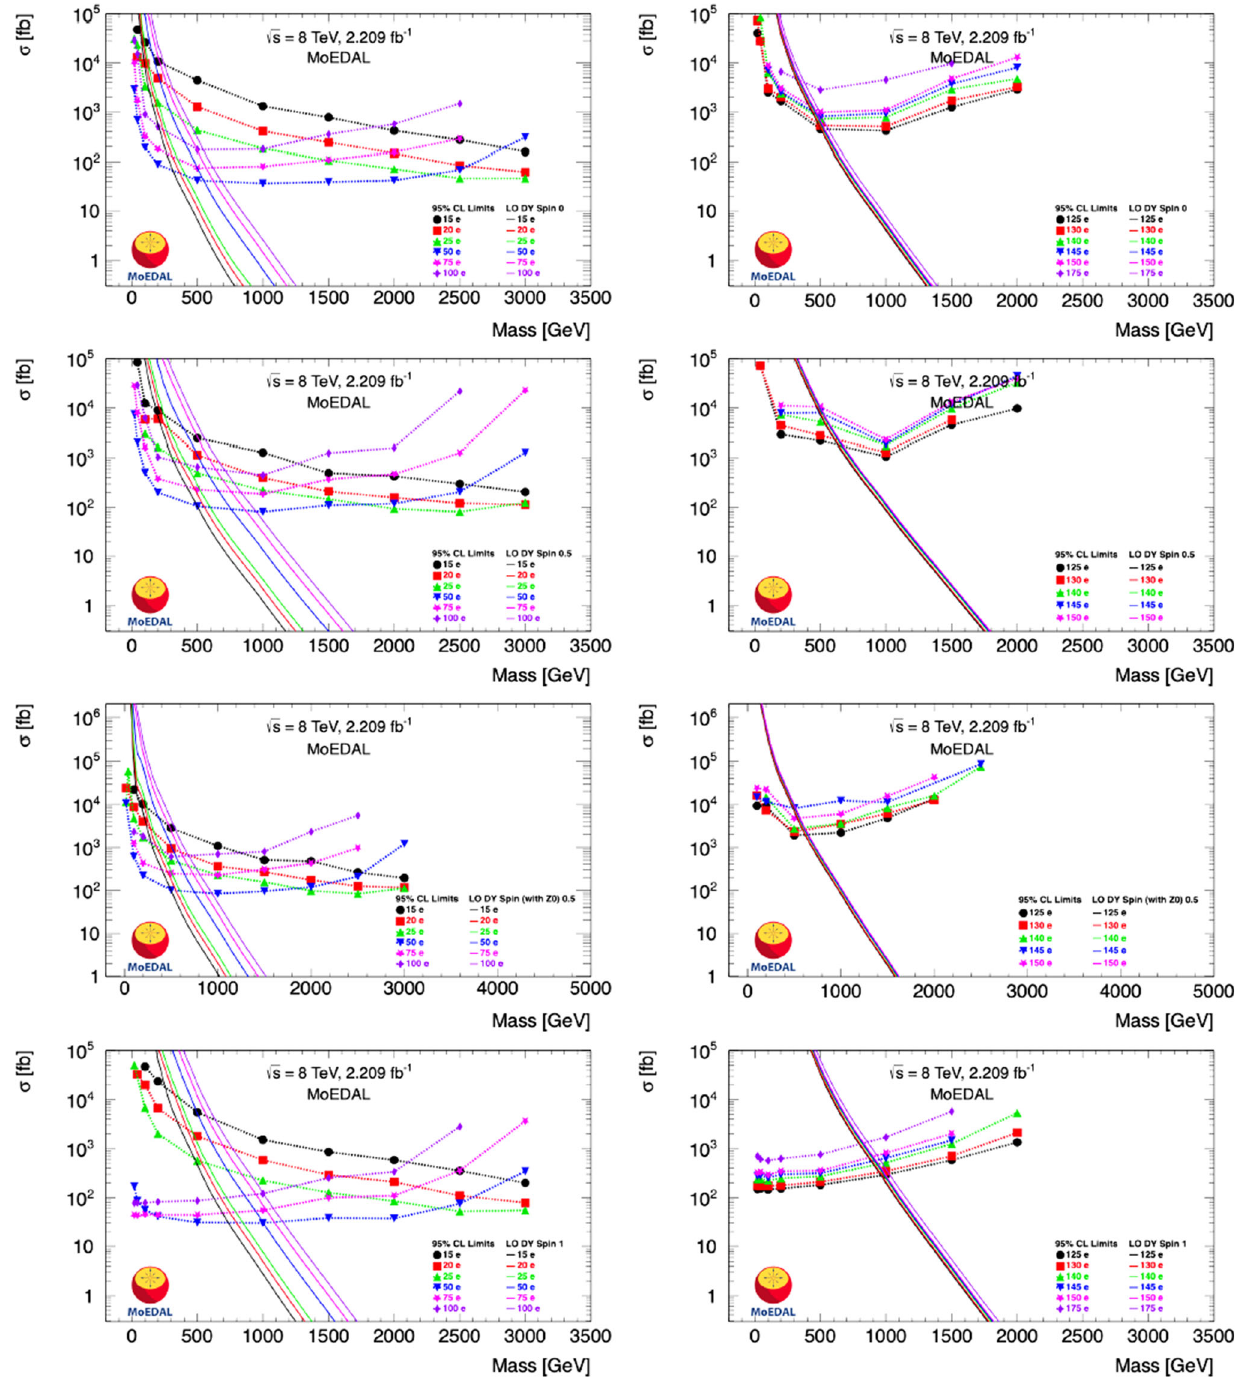
Fig. 19 95% C.L. upper limits to the cross-section using as a measure a DY model with single virtual photon exchange for spin of 0 , 1 / 2 and 1 HECO production. Upper limits for the production of spin-1/2 HECOS